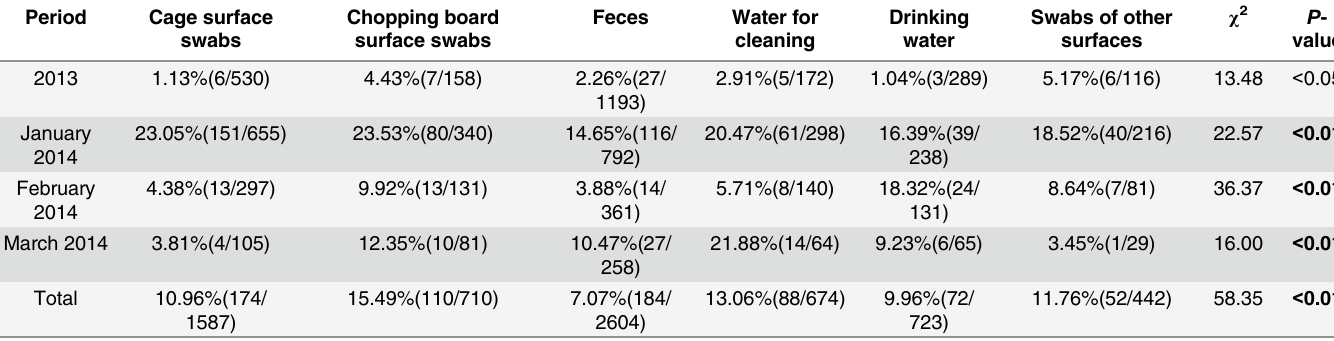
Table 2. Prevalence of H7N9 virus among sample types obtained between January 2013 and March 2014.